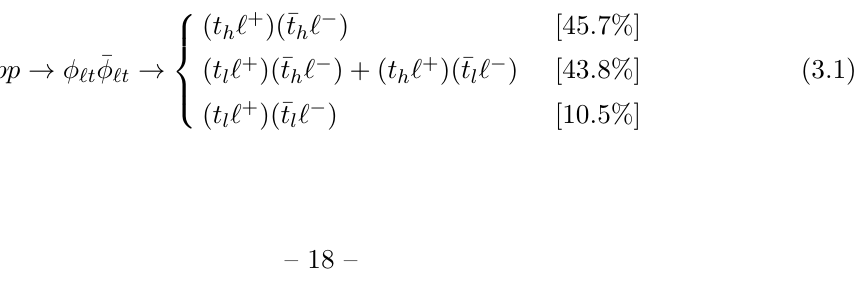
Table 6 . ( Left ) 95% CL lower limits on the masses of scalar LQs S with (cid:22) -factors equal to one so that no recasts are necessary. The limits are adopted from RPV stop searches from ATLAS [17] (see (cid:12)gure 13 and (cid:12)gure 5). ( Right ) Estimated 95% CL recast lower limits on the masses of vector LQs V eb and V (cid:22)b